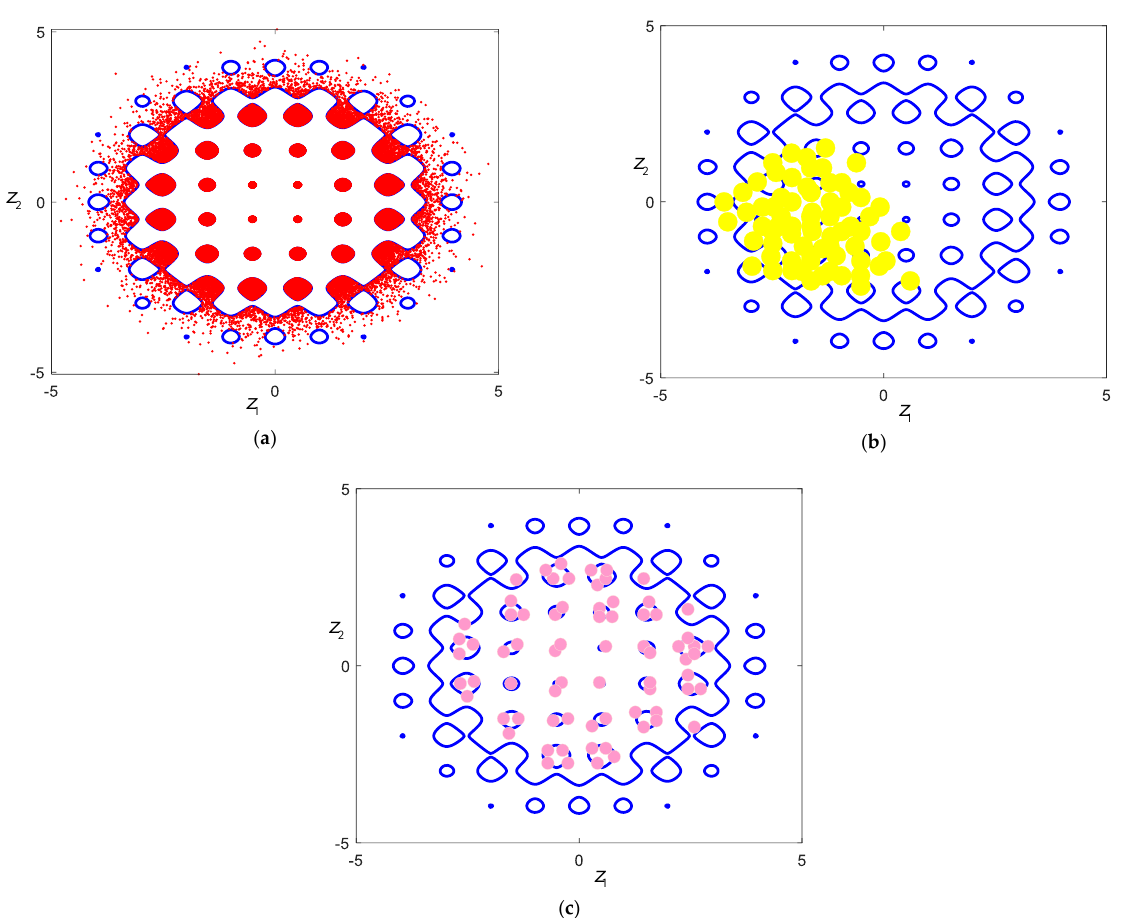
Figure 4. A case study on the optimal IS PDF. ( a ) 2D problem with multiple interested domains; ( b ) Sampling result obtained by IS in Figure 3; ( c ) Sampling result obtained by optimal IS PDF.